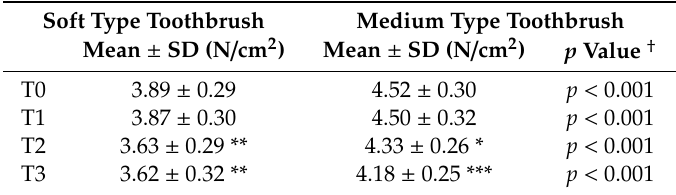
Table 1. Changes in bristle sti ff ness of soft and medium toothbrushes.